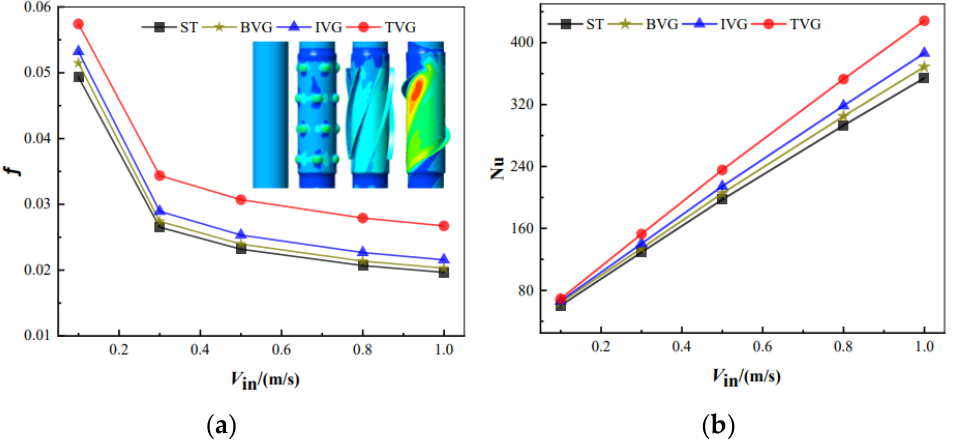
Figure 15. Influence of inlet velocity on strengthening parameters. ( a ) Influence of the inlet velocity on the friction coefficient f ; ( b ) influence of the inlet velocity on the Nusselt number Nu.